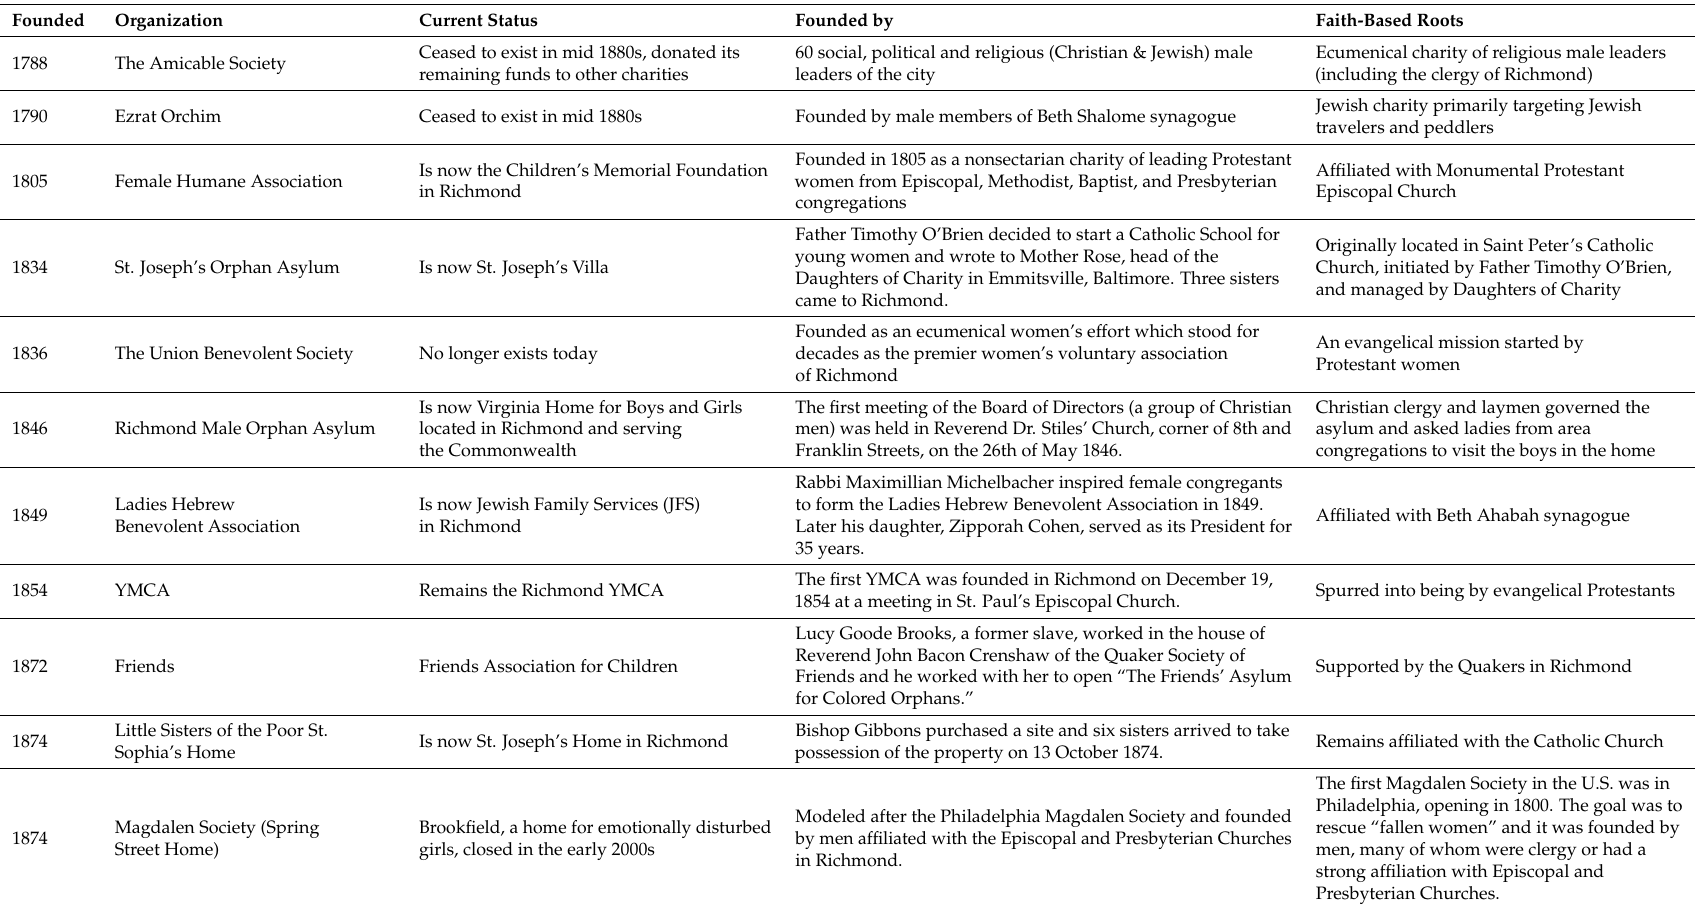
Table 1. Religious Roots of Societies and Charities in Richmond, Virginia